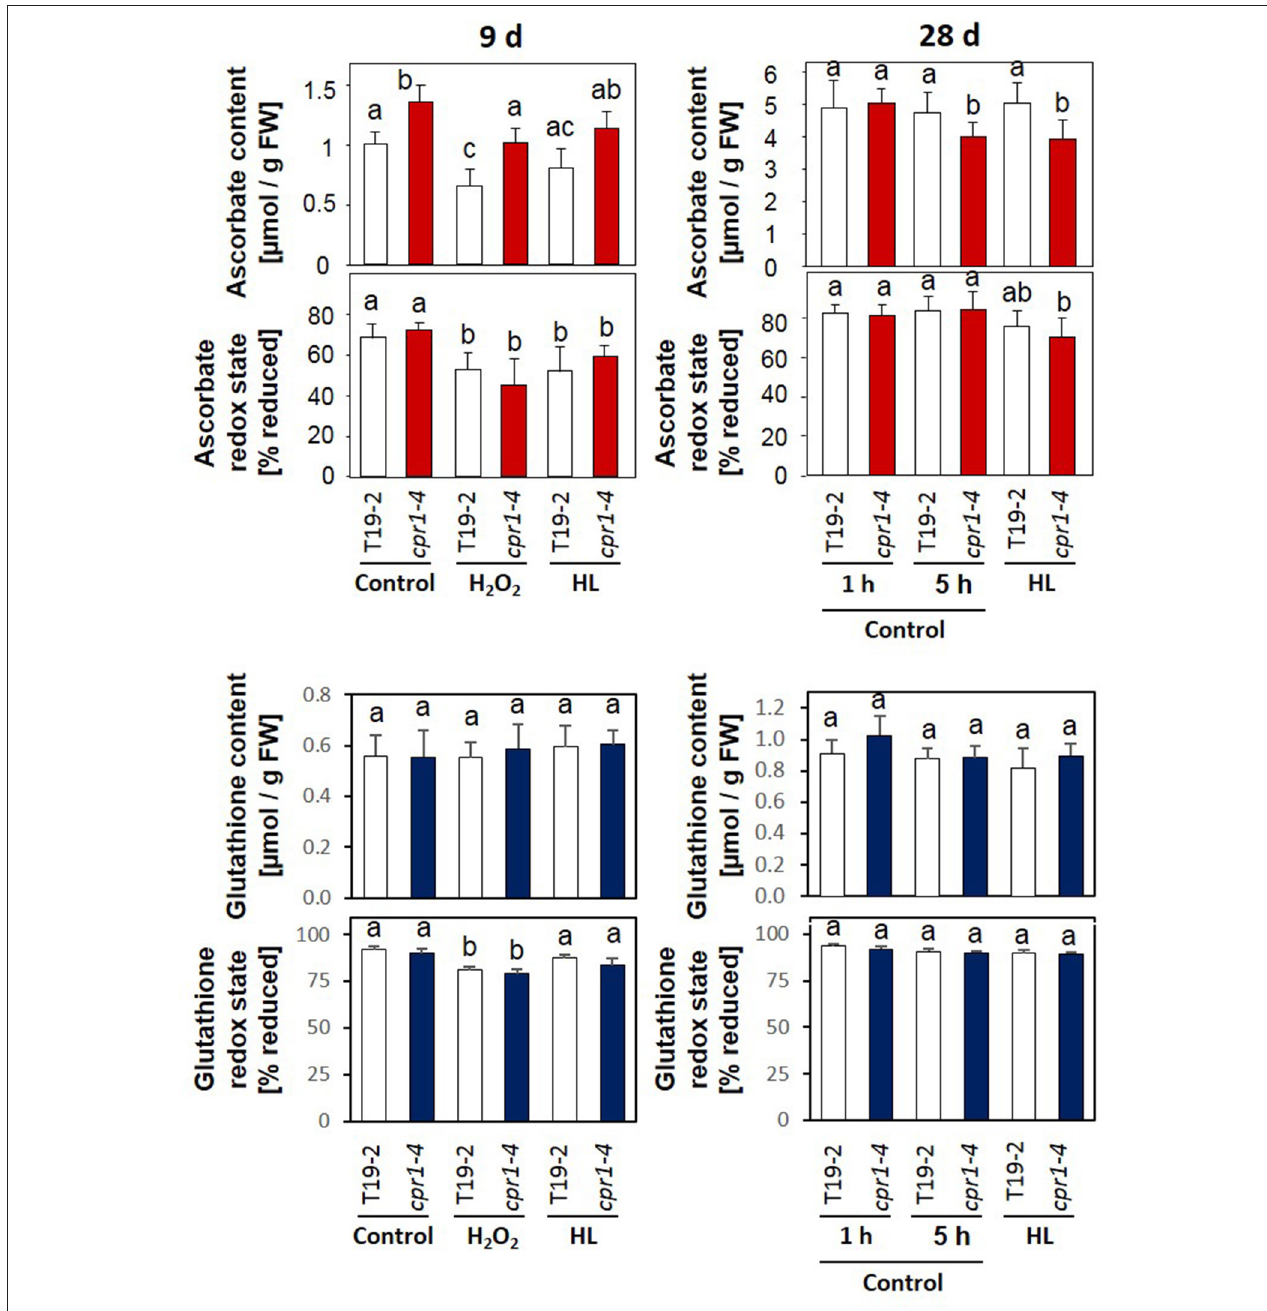
FIGURE 9 | Ascorbate and glutathione contents and redox states in 9-day-old seedlings and 4-week-old rosette plants. Sterile grown 9-day-old seedlings were infiltrated with 10 mM H 2 O 2 or exposed to 800 µ mol photons m − 2 s − 1 (HL), while floating on MS-medium for 4 h. The 4-week-old plants were exposed to 100 µ mol photons m − 2 s − 1 (control conditions) or 800 µ mol photons m − 2 s − 1 (HL) for 4 h starting 1 h after onset of the light-phase to which the plants were acclimated. The ascorbate and glutathione contents and the redox states (amount of reduced form/total amount of glutathione or ascorbate) of the ascorbate pool were determined for 8–12 plants per treatment and genotype. Statistically significant differences are labeled with different letters (ANOVA, P < 0.1). Dehydroascorbate/ascorbate and GSSG/2 × GSH ratios calculated from the same data are depicted in Supplementary Figure 4.